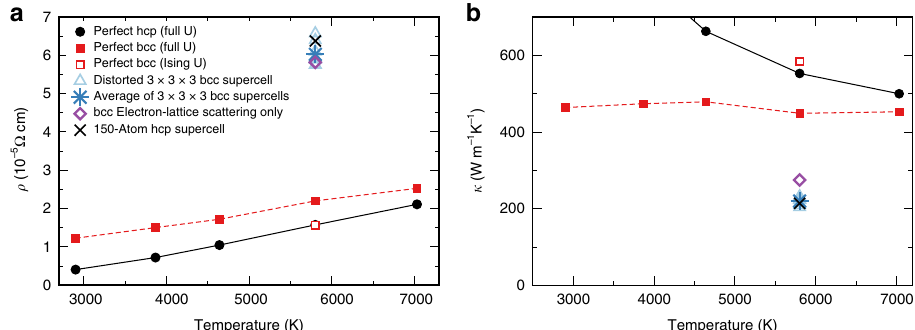
Fig. 1 Electrical and thermal conductivity of iron under Earth ’ s inner-core conditions. a The total resistivity of iron at Earth ’ s core volume (7 Å 3 per atom, density 13.2 g cm − 3 ) obtained by the density-functional theory + dynamical mean- fi eld theory (DFT + DMFT) method. The curves vs. temperature with fi lled circles/squares are for the perfect hexagonal close-packed (hcp) 12 and body-centered cubic (bcc) unit cells, respectively, calculated with the full rotationally invariant Coulomb vertex U . The rest of shown data is obtained using the density – density (Ising) vertex. The empty red square is the perfect bcc result. In the case of perfect lattices, the electron-lattice-scattering (ELS) term is absent, and the resistivity is due to the electron – electron-scattering (EES) term only. The empty triangles are for eight different distorted 3 × 3 × 3 bcc supercells. The bold blue star is the average value over the distorted bcc supercells. The black cross is the average value over the representative 150-atom hcp supercell. The ELS resistivity calculated within DFT for bcc (purple empty diamond) is also shown. b The total thermal conductivity of iron at Earth ’ s core volume obtained by DFT + DMFT. The meaning of symbols is the same as for panel ( a